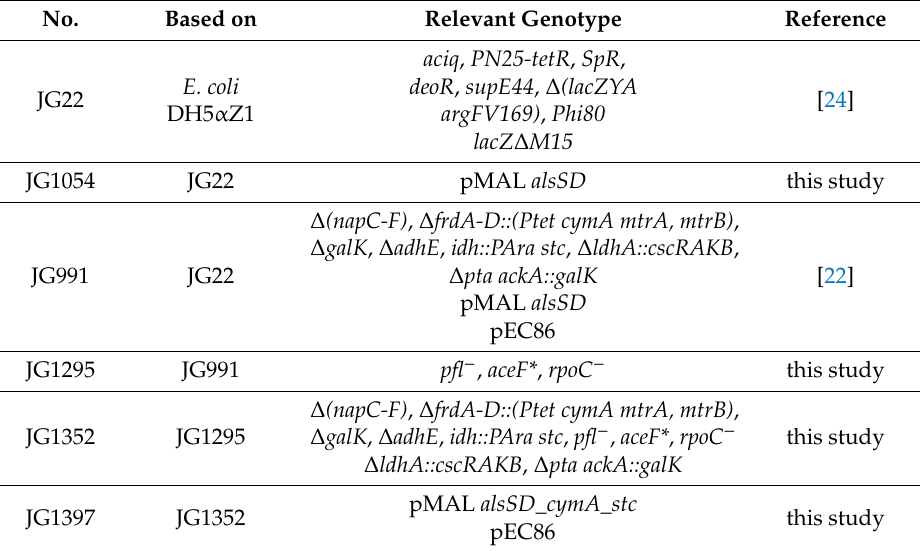
Table 1. Strains used in this study.